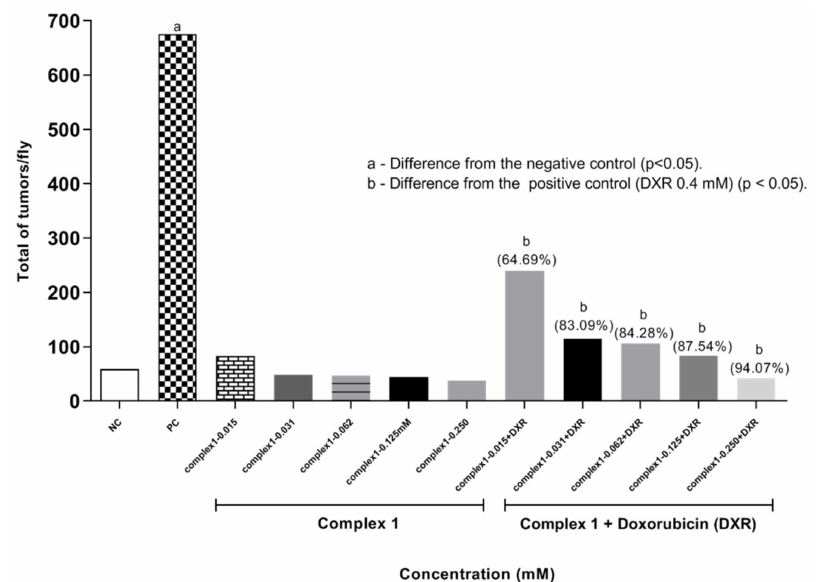
Figure 4. Tumor clones observed in D. melanogaster , heterozygote for the wts tumor suppressor gene. Flies were treated with complex 1 isolated and associated with Doxorubicin. Statistical diagnosis was performed according to Mann–Whitney Test. Level of significance p < 0.05. Percentage (%) represents tumor reduction when complex 1 was associated with DXR. NC: negative control (flies treated with reverse osmosis water). PC: positive control (flies treated with 0.4 mM